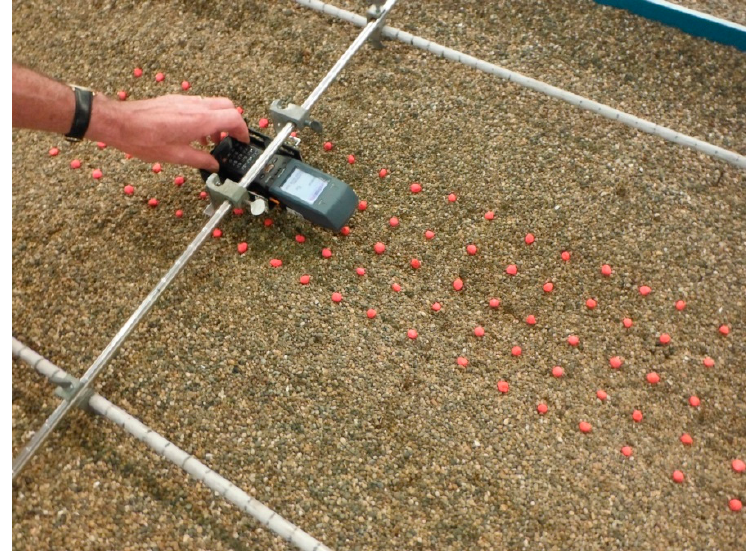
Figure 5. The locations of the array of 100 particles being read by the RFID reader before the second experiment.